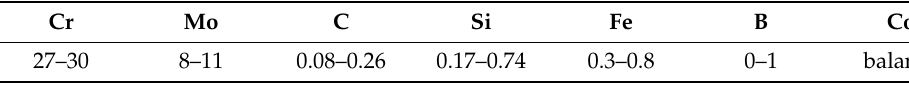
Table 1. Chemical composition of the studied alloys (wt%).